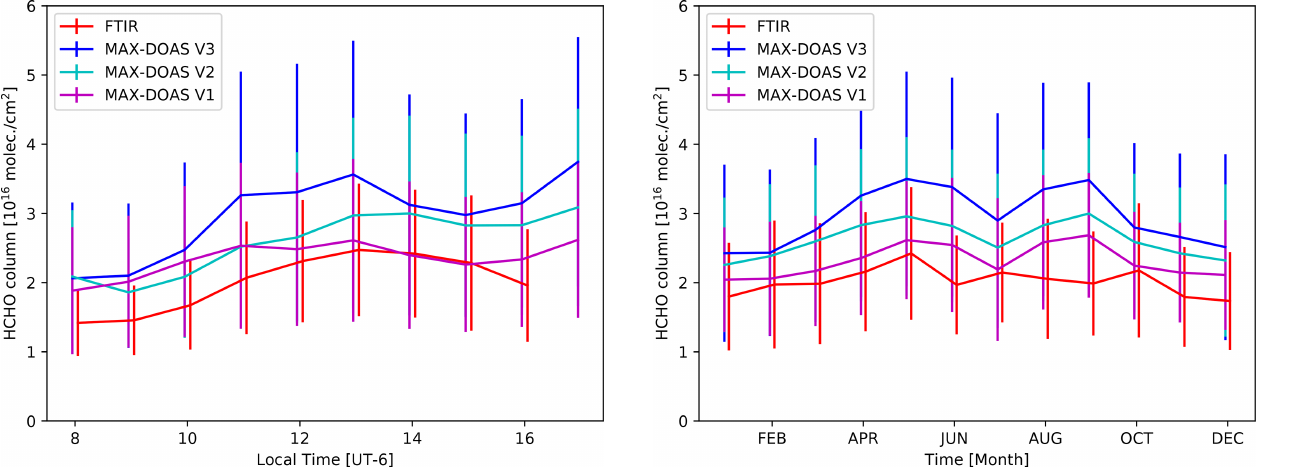
Figure 3. Seasonal FTIR (red), MAX-DOAS V3 (blue), MAX- DOAS V1 (magenta) and MAX-DOAS V2 (cyan) cycles at UNAM. Vertical lines represent the standard deviation of all conducted mea- surements during each